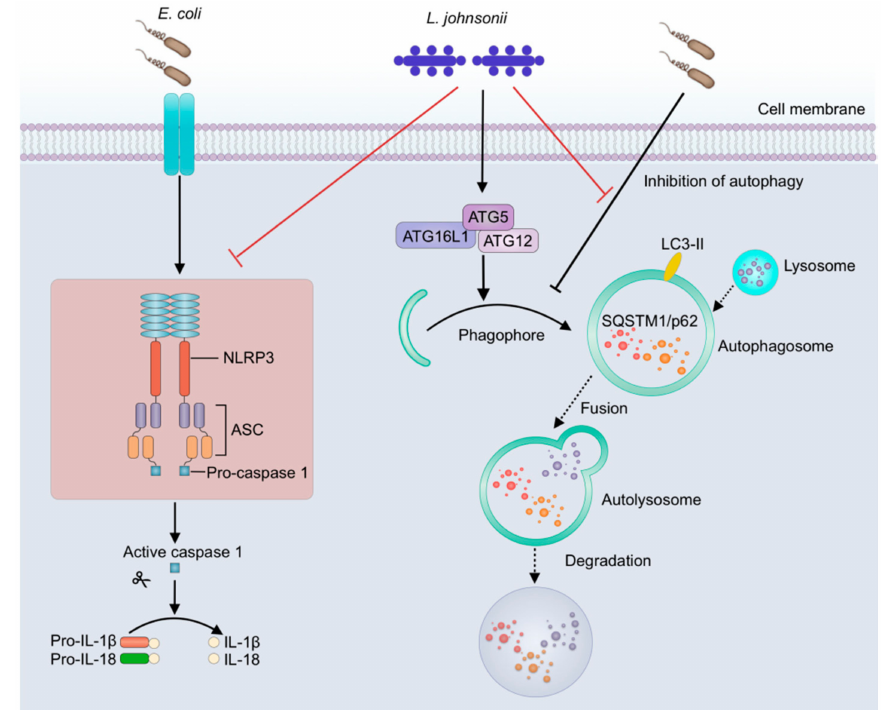
Figure 6. L. johnsonii L531 restricts NLRP3 inflammasome activity and weakens the inhibitory e ff ect of E. coli on autophagy through promoting ATG5 / ATG16L1-mediated autophagy. L. johnsonii L531 attenuates E. coli -induced inflammation and cell damage through restricting NLRP3 inflammasome activity and promoting ATG5 / ATG16L1-mediated autophagy in PMECs. Full lines represent the results of the present study, and dashed lines represent the conclusions drawn in other